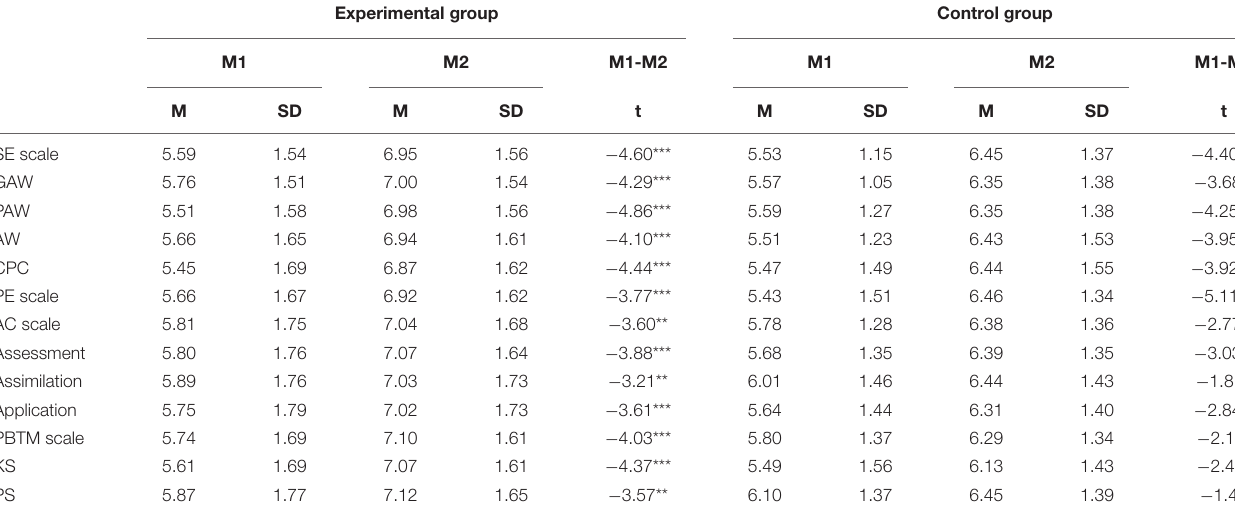
TABLE 2 | A Study of the independence value between the control groups and experimental groups.